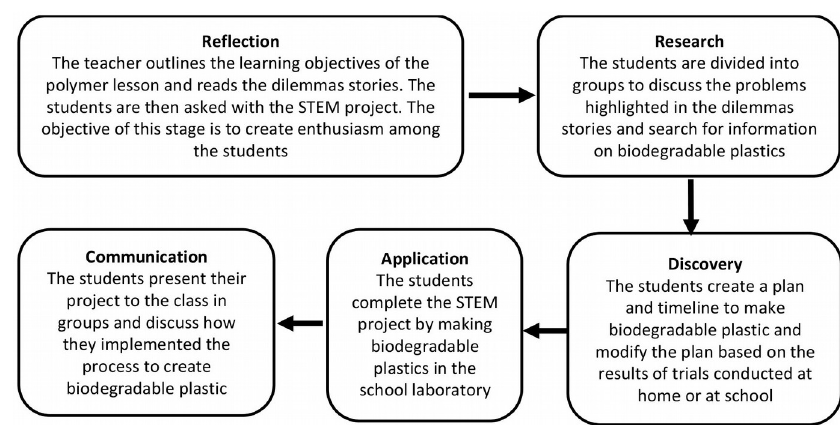
Figure 2. The five stages of integrating dilemmas stories with STEM